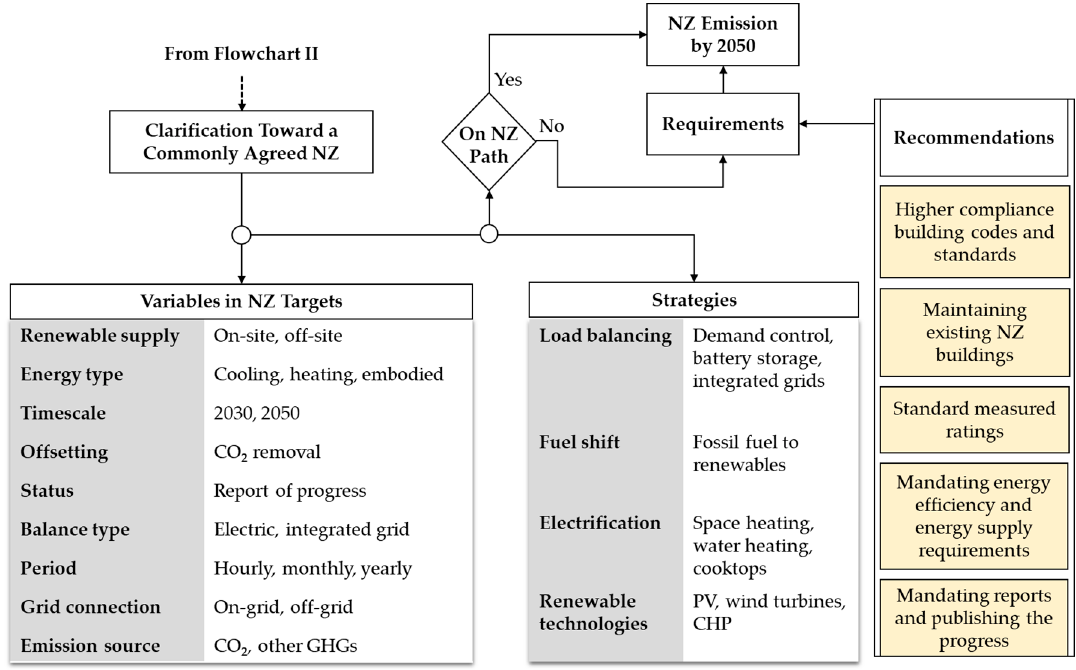
Figure 4. Flowchart II, net zero variable parameters in energy balance.